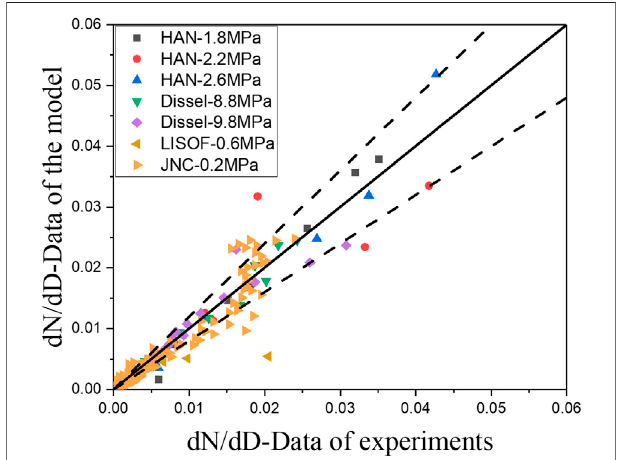
FIGURE 8 | Relative error of droplet size number obtained by the model constrained with momentum equation.